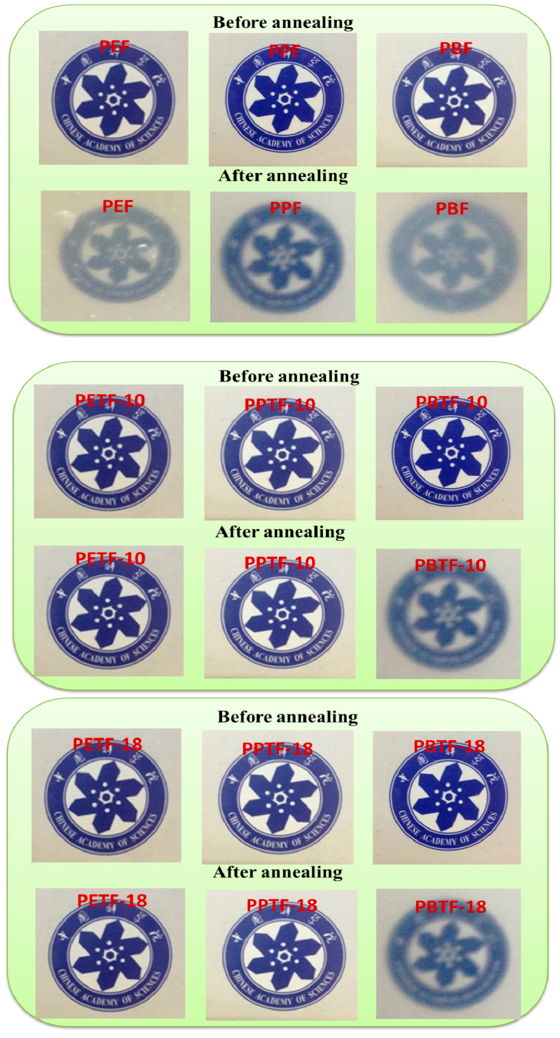
Figure 5. Optical image of PEF, PPF, PBF, and the copolyesters modified with CBDO films before